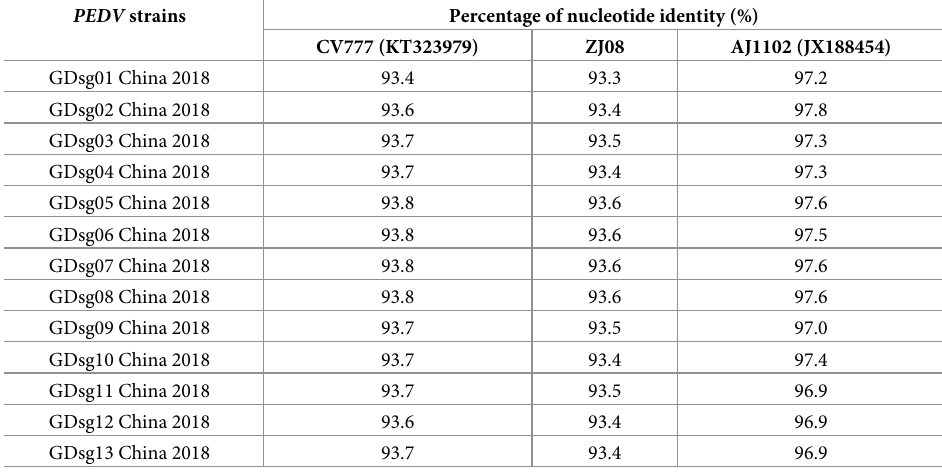
Table 4. Sequence comparison of S gene of 13 PEDV strains and 3 vaccine